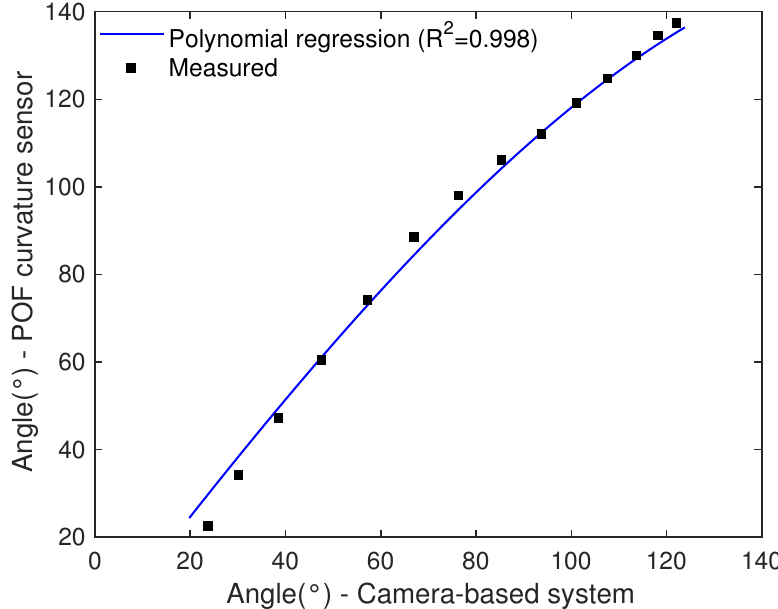
Figure 12. Polynomial regression between camera-based system and POF curvature sensor angular responses for the third flexion cycle of subject